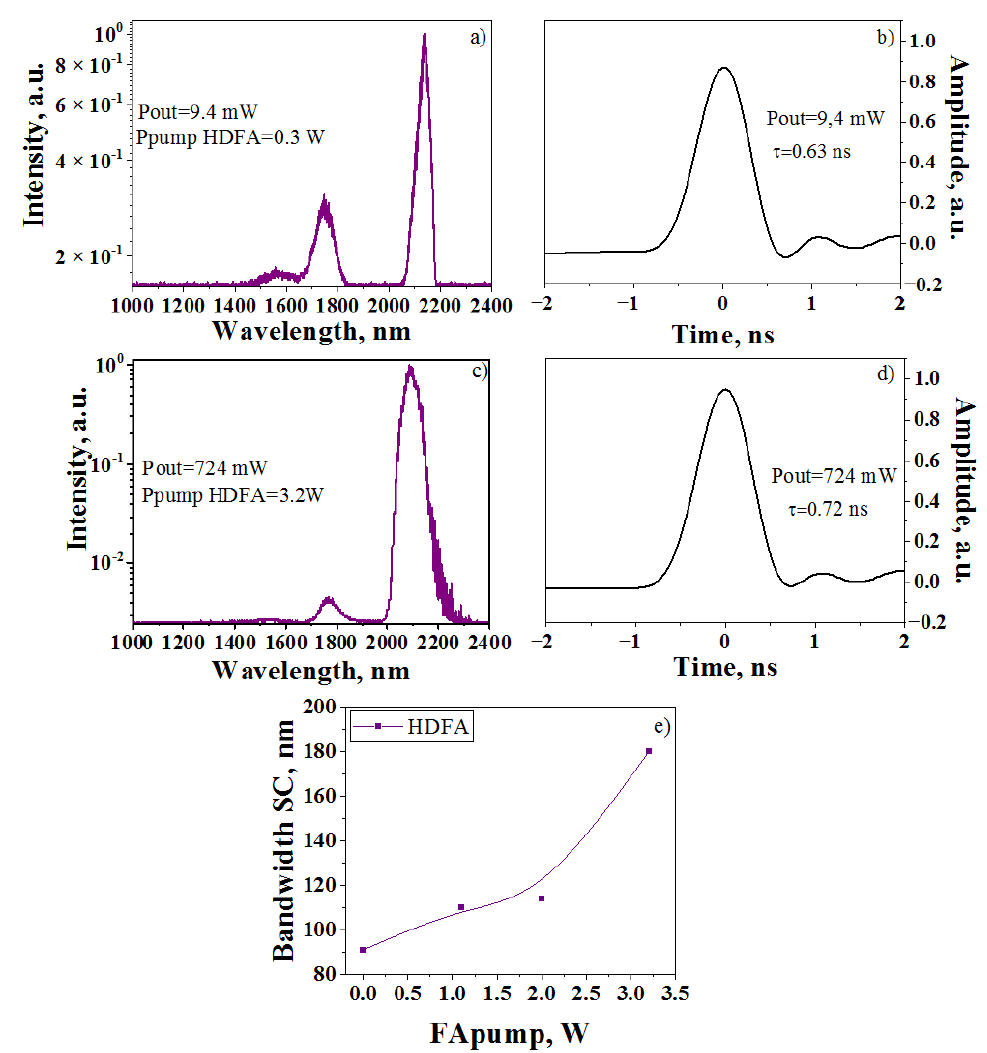
Figure 5. Spectral ( a , c ) and temporal ( b , d ) parameters of radiation after Ho-doped FA obtained at different pump power levels (lower pump level is on the top row) and graph of SC bandwidth vs. pump power ( e ).